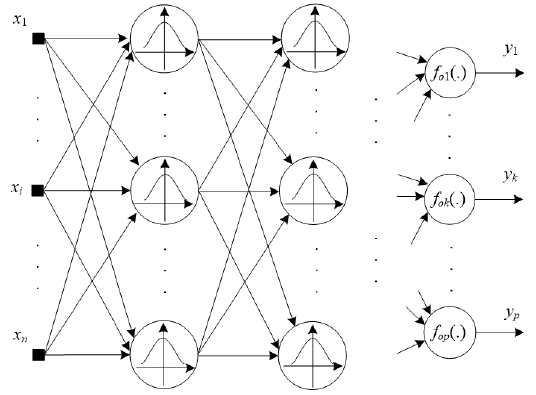
Figure 3. Augmented fuzzy neural